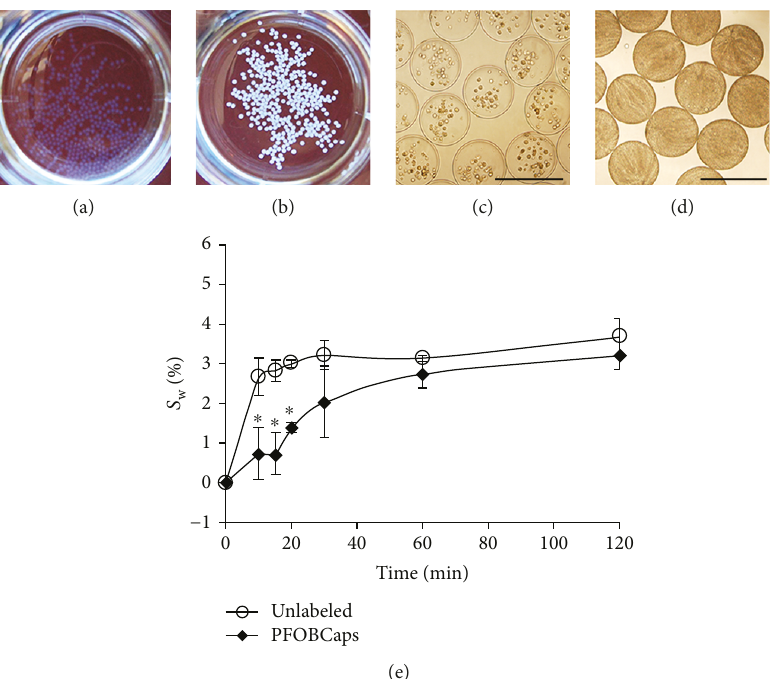
Figure 1: Macroscopic and microscopic images of rabbit MSC-containing microcapsules and their in vitro stability. (a) Unlabeled microcapsules appear transparent. (b) A digital image of PFOBCaps shows higher opacity than unlabeled microcapsules. (c) Light microscopic image of MSC-containing unlabeled microcapsules. (d) Microscopic image of MSC-containing PFOBCaps. (e) The swelling degree of PFOBCaps is signi fi cantly lower than that of unlabeled microcapsules in the fi rst 20 minutes of incubation ( P < 0 01 ). Scale bars represent 500 μ m.